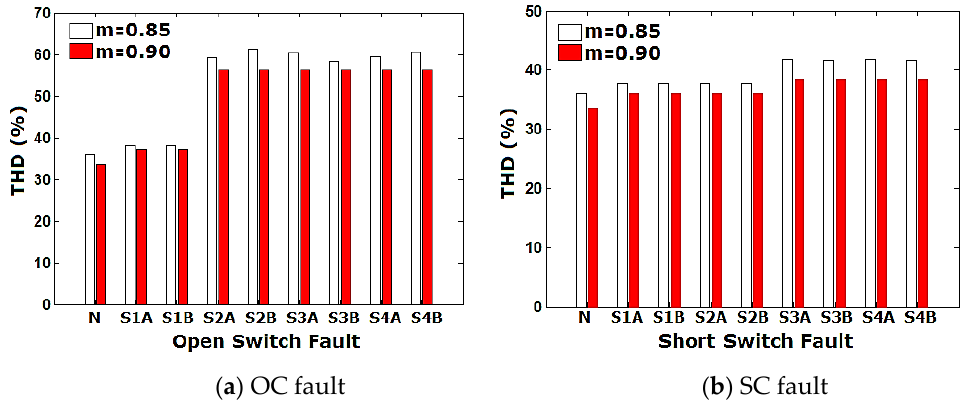
Figure 10. THD value of the output voltage waveform obtained from the FFT technique at different fault cases and different modulation index values.